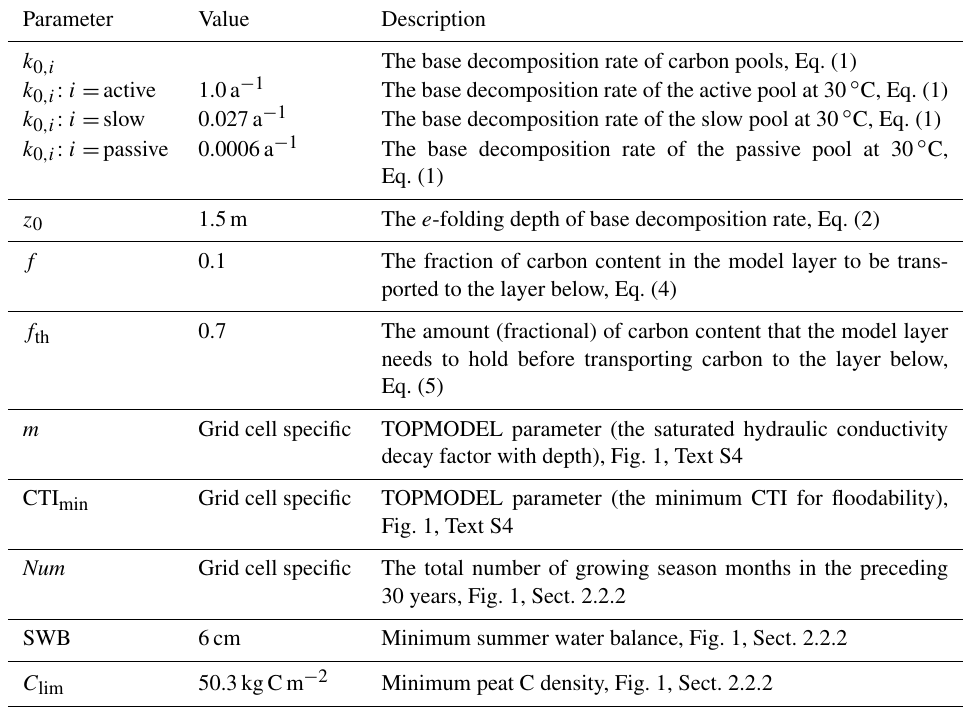
Table 1. Parameters in peatland modules of ORCHIDEE-PEAT v2.0. Parameter Value Description k 0 ,i The base decomposition rate of carbon pools, Eq. (1) k 0 ,i : i = active 1.0a − 1 The base decomposition rate of the active pool at 30 ◦ C, Eq. (1) 0.027a − 1 The base decomposition rate of the slow pool at 30 ◦ C, Eq. (1) 0.0006a − 1 The base decomposition rate of the passive pool at 30 ◦ C, Eq. (1) 1.5m The e -folding depth of base decomposition rate, Eq. (2) 0.1 The fraction of carbon content in the model layer to be trans- ported to the layer below, Eq. (4) 0.7 The amount (fractional) of carbon content that the model layer needs to hold before transporting carbon to the layer below, Eq. (5) m Grid cell specific TOPMODEL parameter (the saturated hydraulic conductivity decay factor with depth), Fig. 1, Text S4 CTI min Grid cell specific TOPMODEL parameter (the minimum CTI for floodability), Fig. 1, Text S4 Num Grid cell specific The total number of growing season months in the preceding 30 years, Fig. 1, Sect. 2.2.2 SWB 6cm Minimum summer water balance, Fig. 1, Sect. 2.2.2 C lim 50.3kgCm − 2 Minimum peat C density, Fig. 1, Sect.